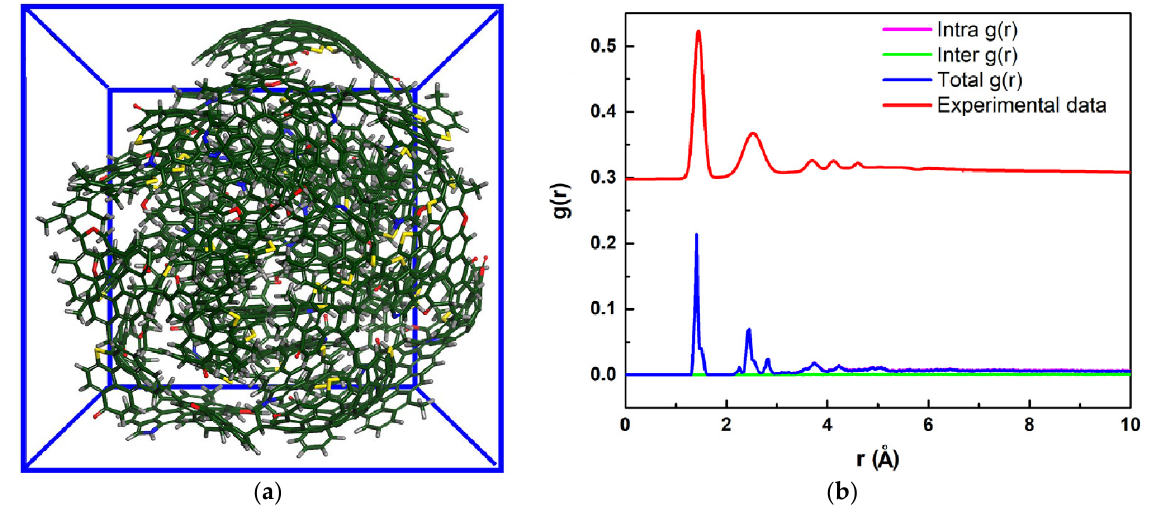
Figure 12. ( a ) Atomic representation (reaction box of 64 × 64 × 64 Å) and ( b ) pair correlation function [84]. Reprinted/adapted with permission from Ref. [84]. 2018, Combustion and Flame.